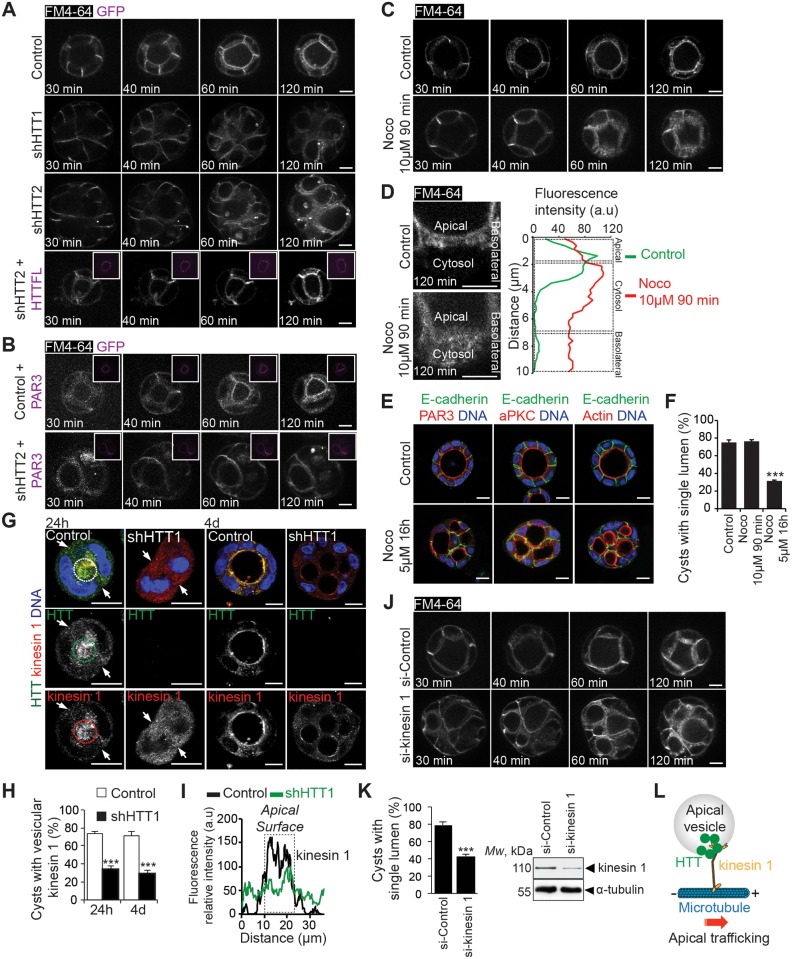
HTT regulates apical vesicular trafficking in a microtubule-dependent manner.(A–C) FM64-4 4-day MDCK 3-D structures were video-recorded. Maximum intensity and z projections are shown. Magnifications are shown in (D) (left; 120 min). (D) Representative line-scan analysis (relative fluorescence intensity; at least 20 cells were analyzed per condition). (E) Four-day MDCK 3-D structures stained for E-cadherin and PAR3, aPKC, or F-actin. (F) Percentage of acini with normal lumen (control: n = 94 acini, Noco 10 μM 90 min: n = 67 acini, Noco 5 μM 16h: n = 72 acini). (G) Twenty-four–hour and four-day MDCK 3-D structures stained for HTT and kinesin 1. Arrows indicate the basolateral compartment, and dashed ellipses indicate the apical surface. Colocalization of HTT and kinesin 1 is displayed in yellow (merge). (H) Percentage of 3-D structures with vesicular kinesin 1 staining (control: n = 22 24h-acini and n = 26 day 4-acini, shHTT1: n = 25 24h-acini and n = 25 day 4-acini). (I) Representative line-scan analysis (relative fluorescence intensity; at least 20 cells were analyzed per condition). (J) FM64-4 4-day MDCK 3-D structures were video-recorded. Maximum intensity and z projections are shown. (K) Left: percentage of acini with normal lumen (si-Control: n = 30 acini, si-kinesin 1: n = 28 acini), right: western blotting of MDCK cell extracts. (L) Illustration showing HTT and kinesin 1 during microtubule-dependent apical vesicular trafficking. All scale bars, 10 μm. Error bars, SEM. *** p<0.001. Complete statistical analyses with number of measures are detailed in S1 Data.